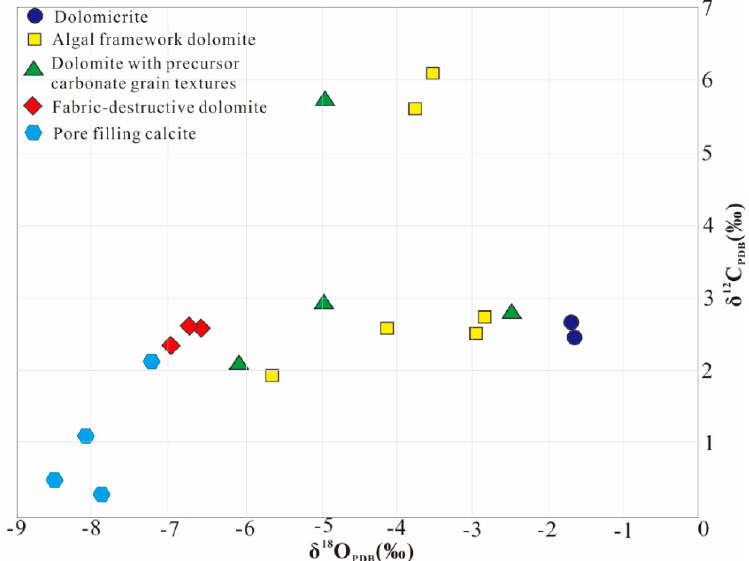
Figure 4. Plot of δ 13 C and δ 18 O values of the dolomicrite, fabric-retentive dolomite, fabric-destructive dolomite, and calcite of the Leikoupo Formation, Western Sichuan Basin.